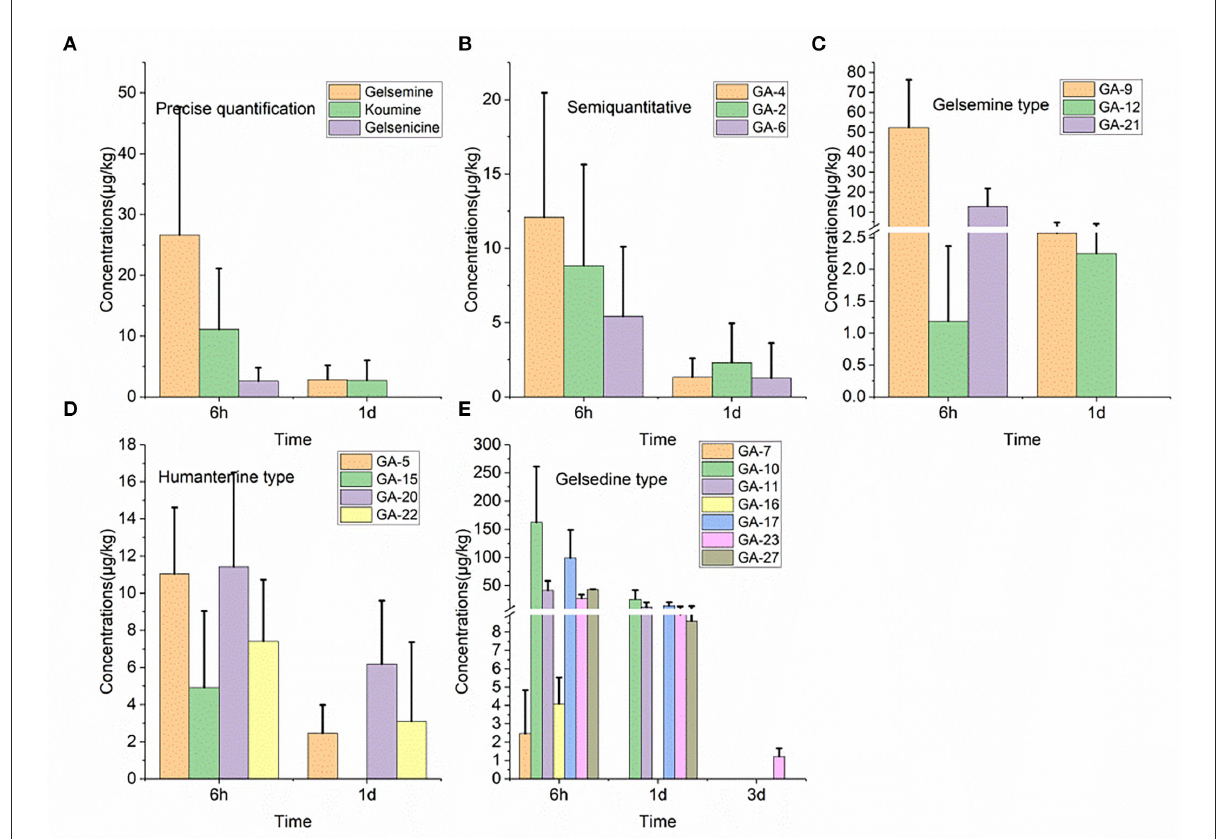
FIGURE1 (A–E) Depletion of Gelsemium alkaloids in pig lung after 45 d of consecutive administered G. elegans powder at a dose of 2% per kilogram feed.